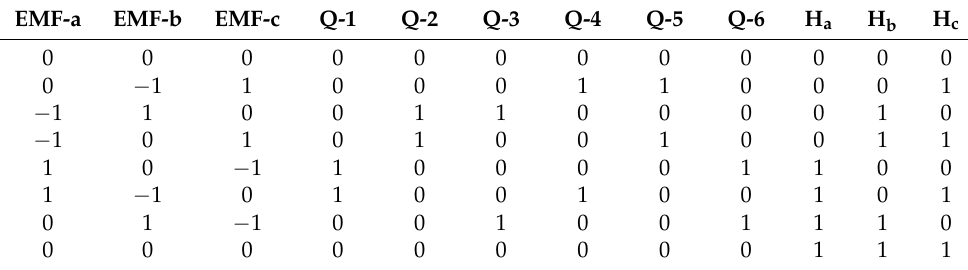
Table 2. Commutation Logic Table for Gate and